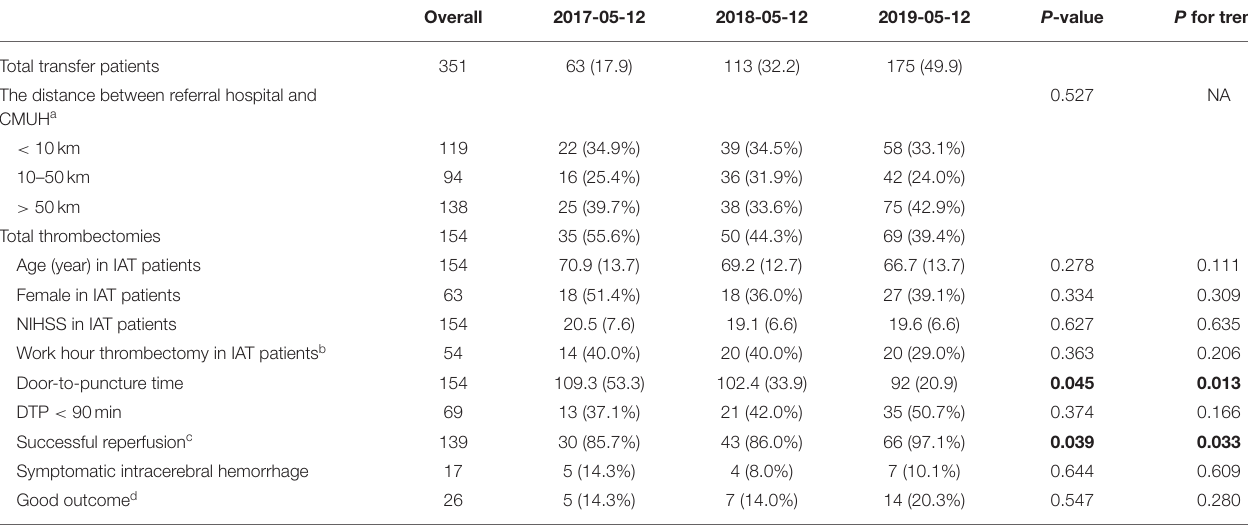
TABLE 1 | Characteristics of transfer cases of the three